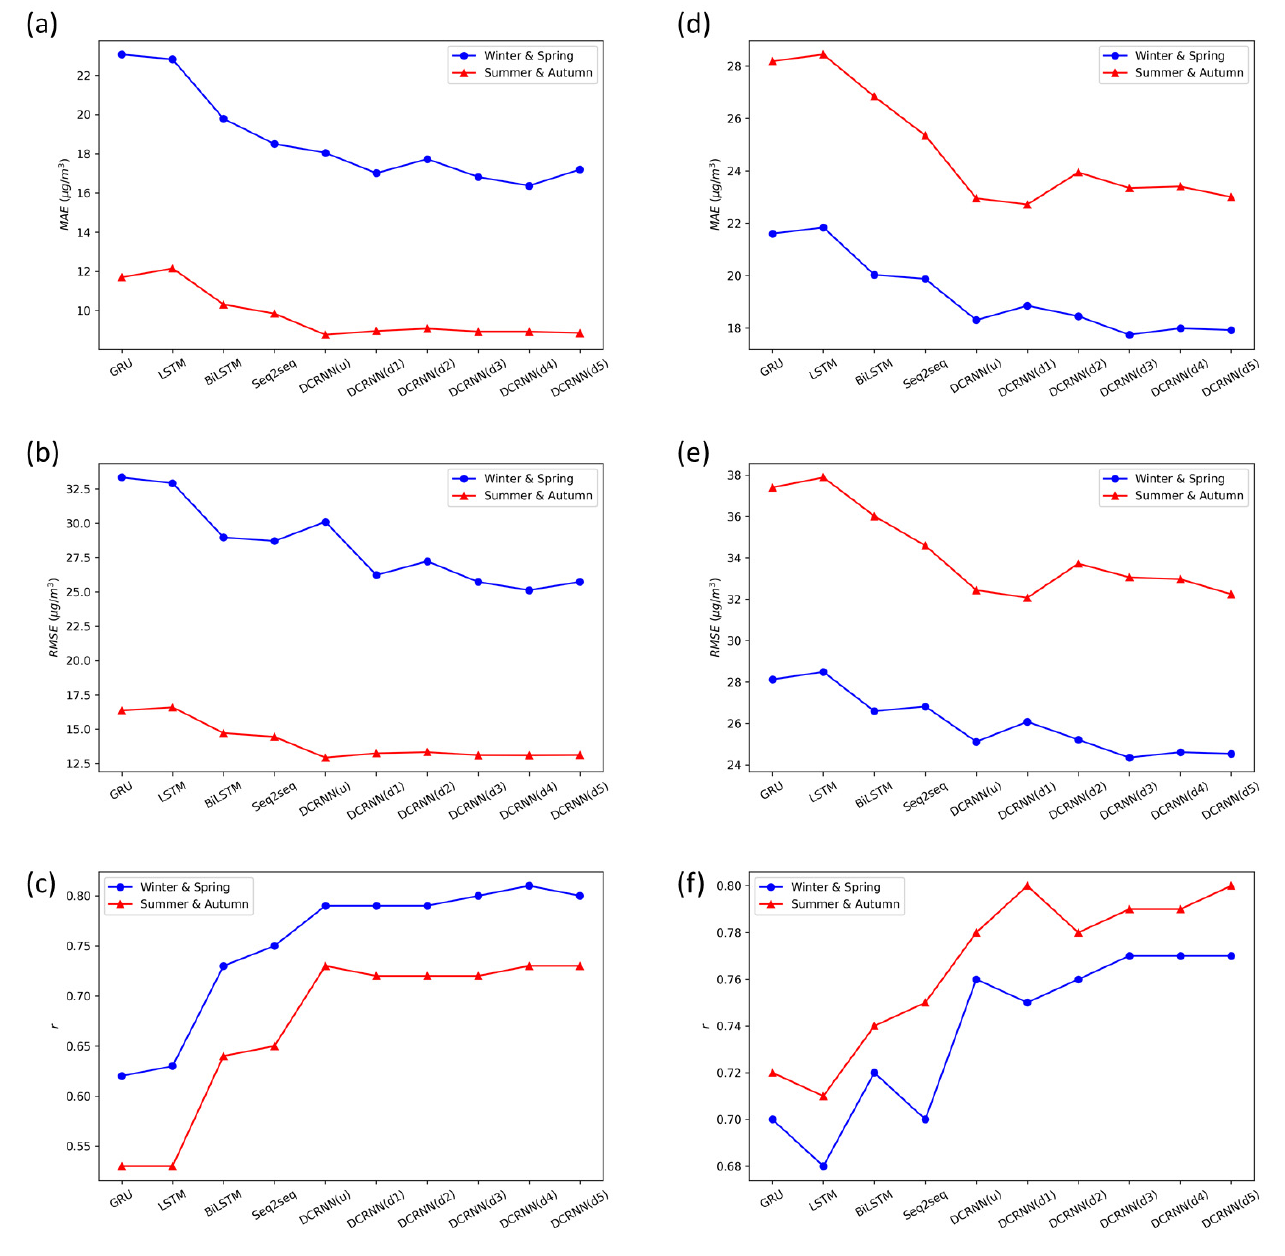
Figure 4. Model comparison between the DCRNN model and baseline models. ( a ) PM 2.5 , MAE; ( b ) PM 2.5 , RMSE; ( c ) PM 2.5 , r; ( d ) ozone, MAE; ( e ) ozone, RMSE; ( f ) ozone, r.